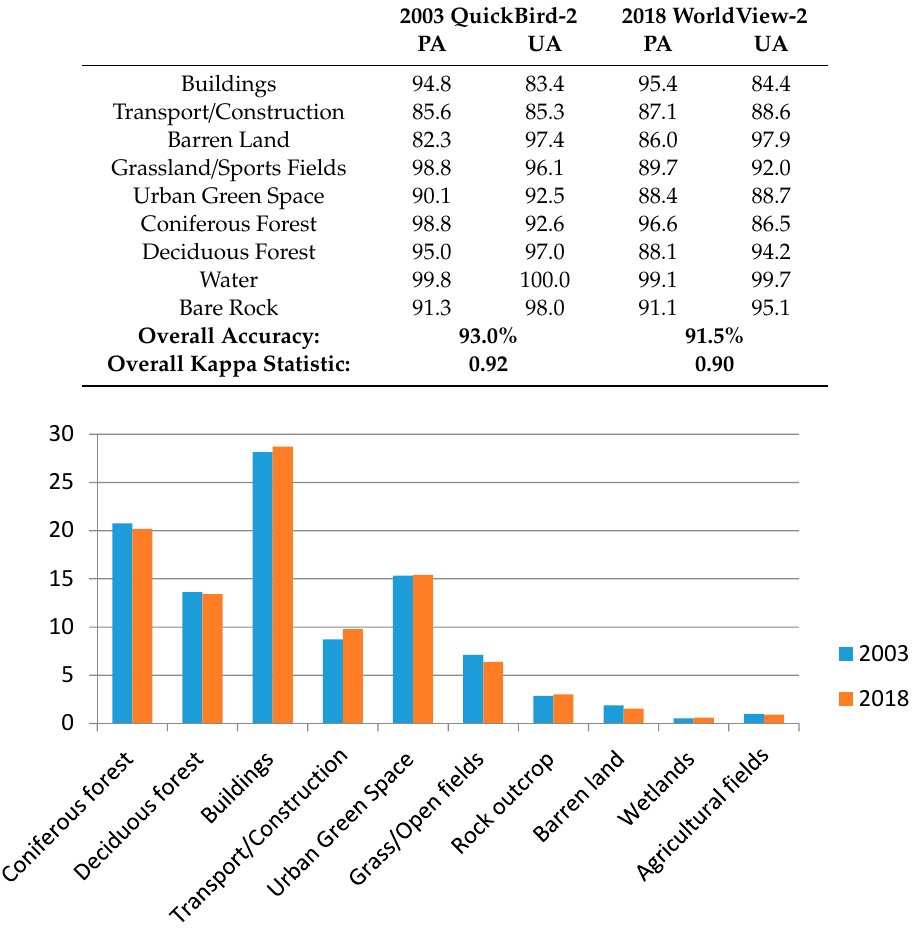
Figure 3. Land area percentage change per land-cover class in Stockholm City between 2003 and 2018.